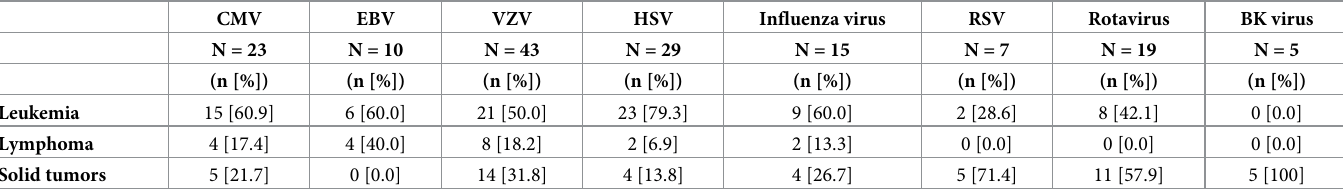
Table 6. Distribution of viral infections in different malignancy